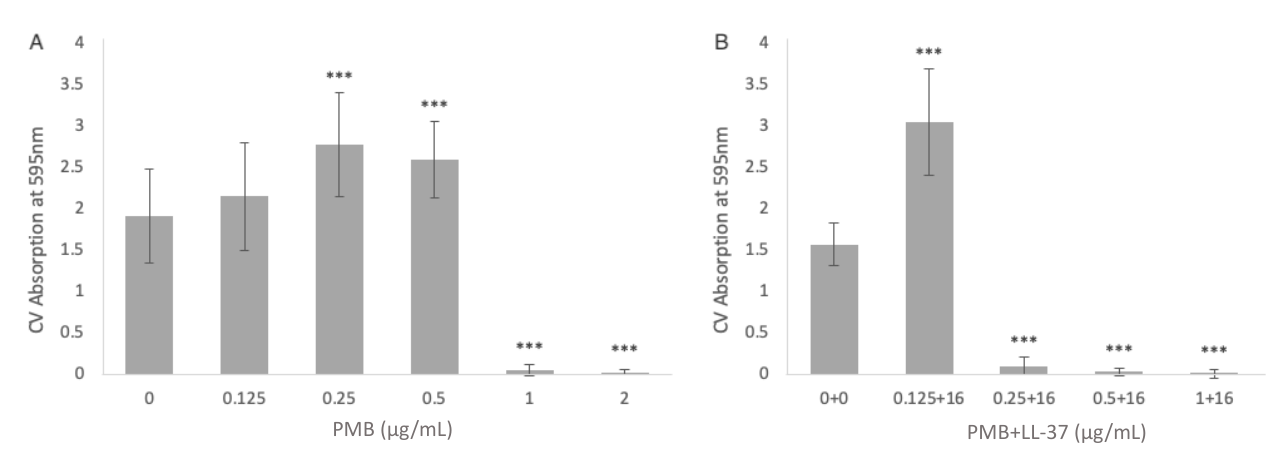
Figure 3. The inhibitory effect of ( A ) PMB alone and ( B ) the combination of PMB + LL-37 on the formation of P. aeruginosa PAO1 biofilms. The ability of PMB, alone and in combination with LL-37, to inhibit P. aeruginosa PAO1 biofilm growth was evaluated via crystal violet staining. ( A ) The amount of P. aeruginosa PAO1 biofilm growth in the presence of single treatments of 0 µ g/mL, 0.125 µ g/mL, 0.25 µ g/mL, and 0.5 µ g/mL, 1 µ g/mL, and 2 µ g/mL PMB. ( B ) The amount of P. aeruginosa PAO1 biofilm growth in the presence of 0 µ g/mL PMB + 0 µ g/mL LL-37, 0.125 µ g/mL PMB + 16 µ g/mL LL-37, 0.25 µ g/mL PMB + 16 µ g/mL LL-37, 0.5 µ g/mL PMB + 16 µ g/mL LL-37, and 1 µ g/mL PMB + 16 µ g/mL LL-37 treatments. The biofilm biomass was measured at 595 nm after an incubation of 24 h at 37 ◦ C. The mean background absorbance values were subtracted from the results for the test wells. The analysis of variance (ANOVA) tests (***, p < 0.001) were calculated for the average values from at least two independent experiments. Each experiment included two independent bacterial cultures, with each condition including data from eight wells of a microtiter plate. Standard deviation bars are